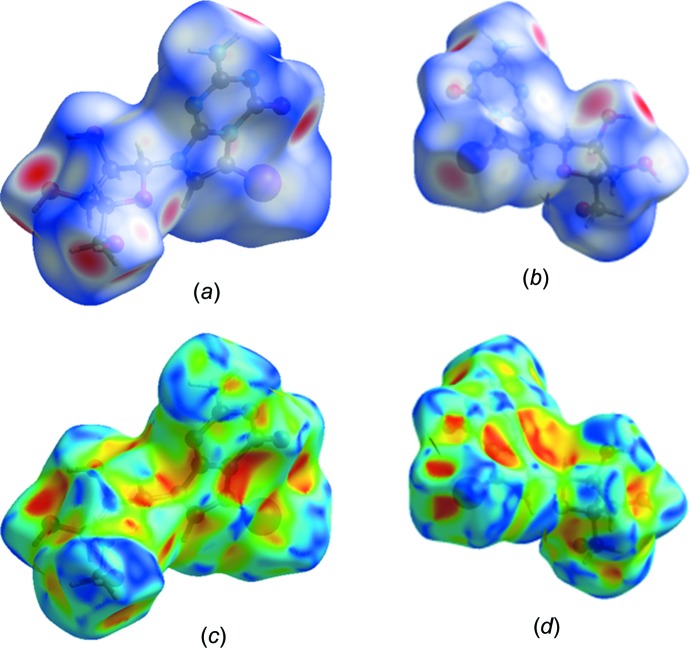
Hirshfeld surface of com­pound 1, mapped over d
norm (−0.5 to 1.5 Å), shown in (a) a front and (b) a back view. The shape index, shown in (c) a front and (d) a back view.